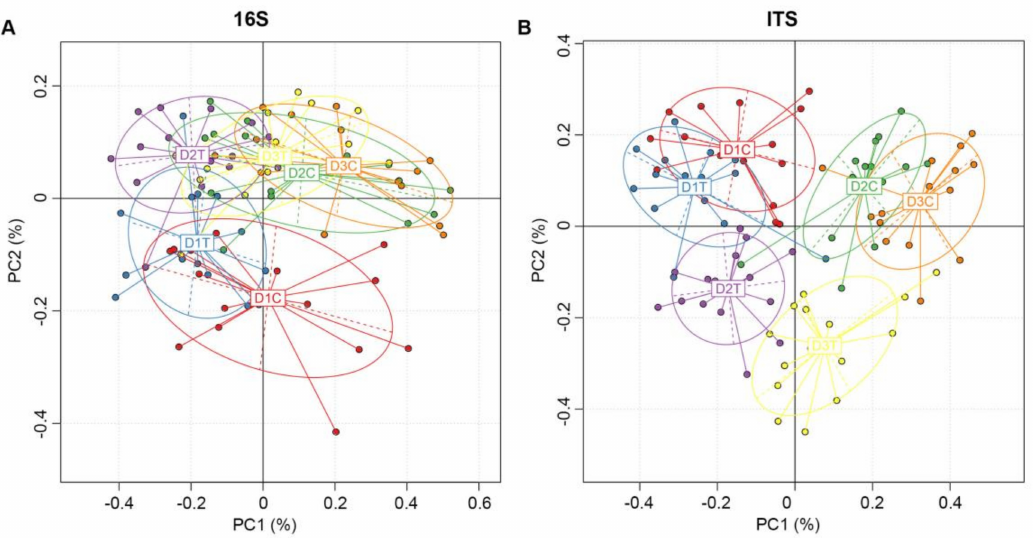
Figure 2. Principal component analysis based on OTU abundance in bacteria ( A ) and fungi ( B ). X-axis represents the mean principal component 1 and Y-axis represents the mean principal component 2. Numbers within parentheses represents contributions of principal components to differences among samples. Each dot represents a soil sample, and different colors represent different